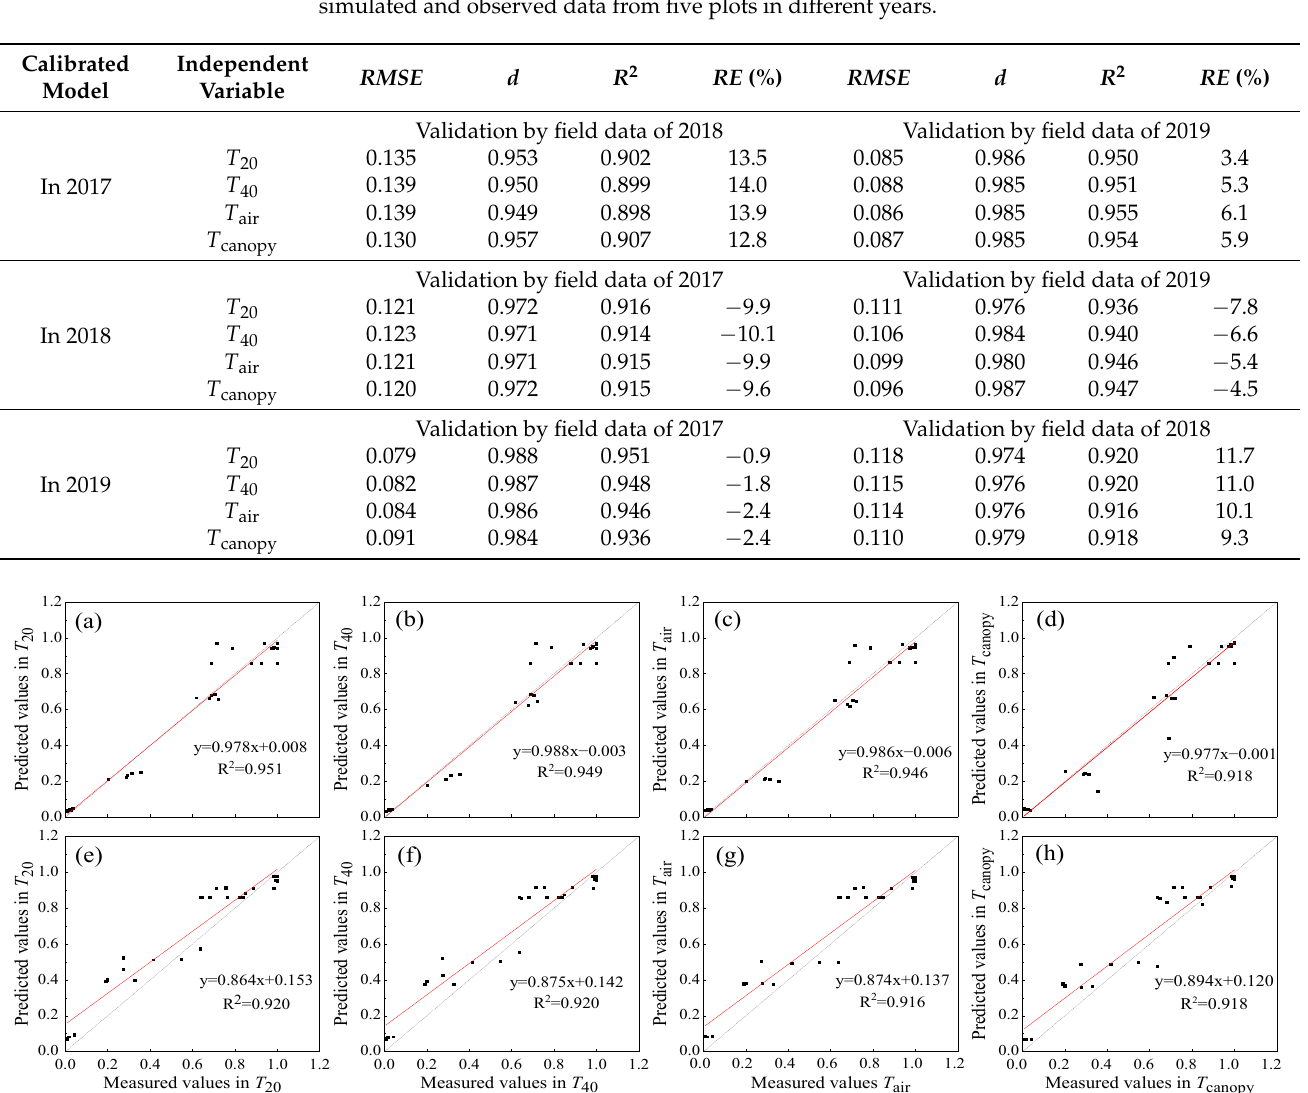
Table 5. Validation results of NR-logistic model of RFBA with T 20 , T 40 , T air , and T canopy between the simulated and observed data from five plots in different years.